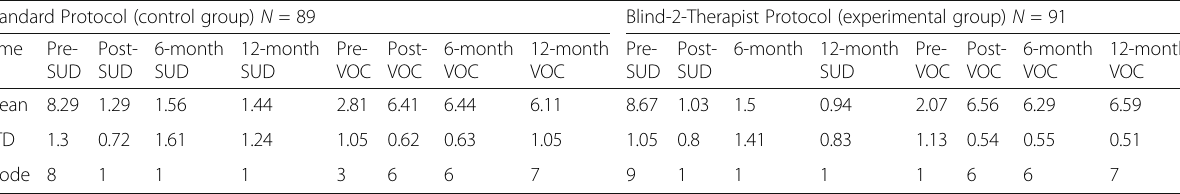
Table 3 Standard Protocol ( N = 89) versus Blind 2 Therapist (N = 91) SUD and VOC, pre-, post- and 6 months follow-up. Mean, SD and mode values Standard Protocol (control group) N = 89 Blind-2-Therapist Protocol (experimental group) N = 91